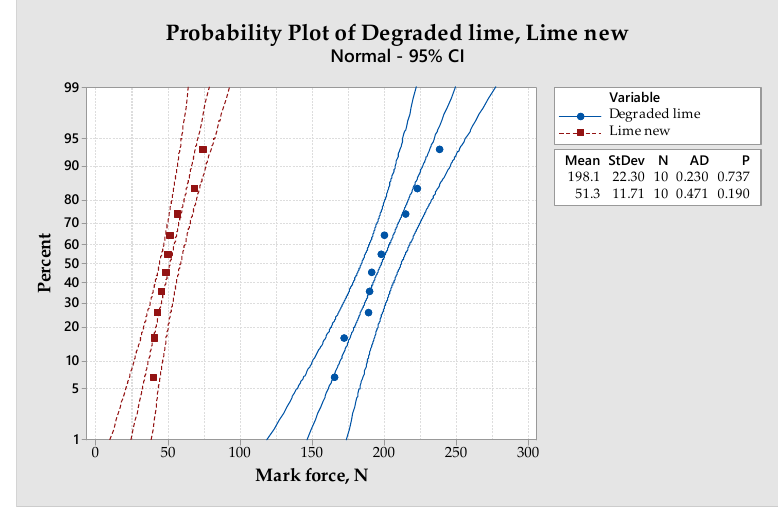
Figure 10. Pressure force obtained with the Mark10 dynamometer.